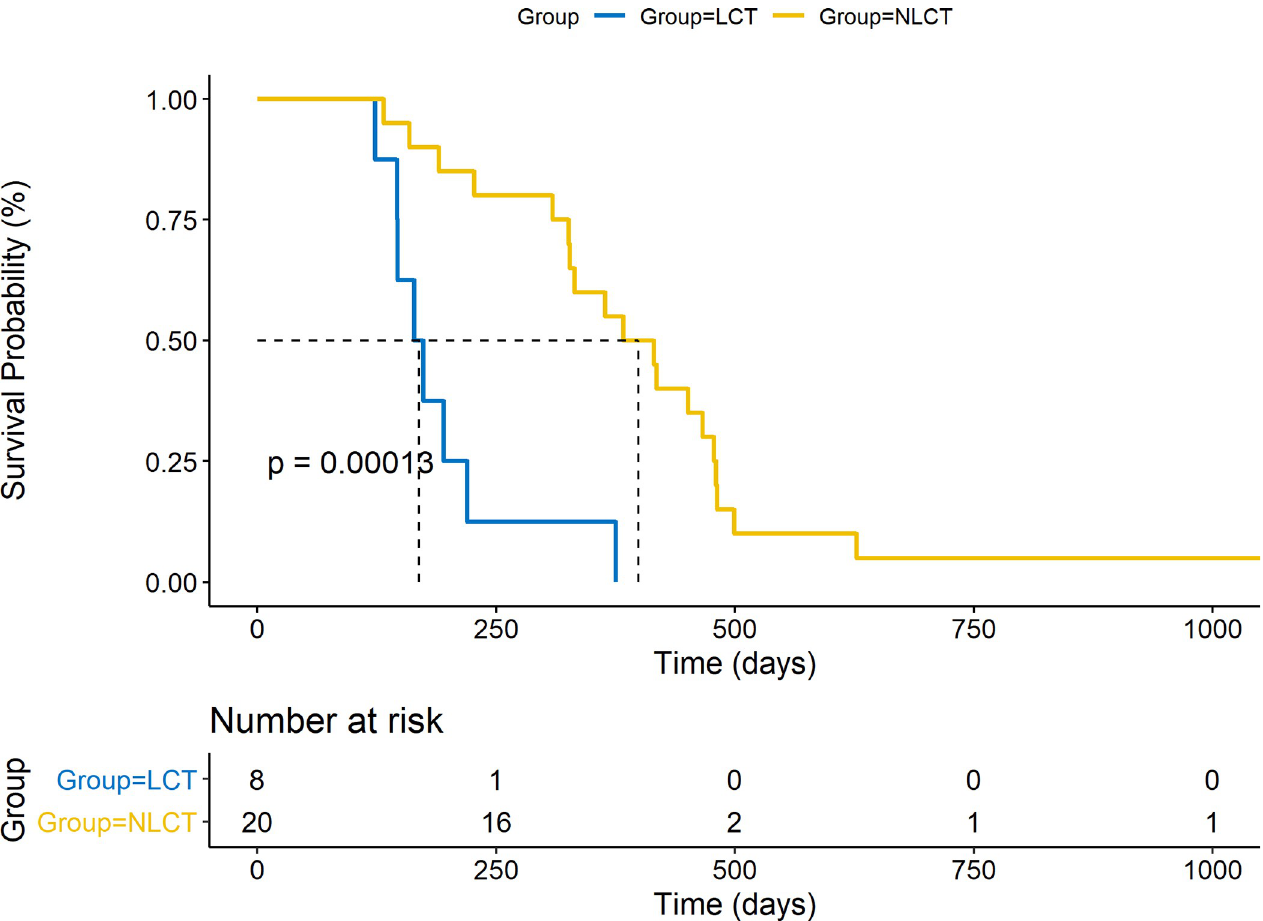
Fig 2. Average time-to-next-treatment (TTNT) analysis measured in days of large cell transformation (LCT) versus non-large cell transformation (NLCT) groups. The LCT group (blue line) demonstrated significantly decreased mean TTNT compared to the NLCT group (yellow line, HR 5.868, 95% CI 0.0623–0.4661, p =